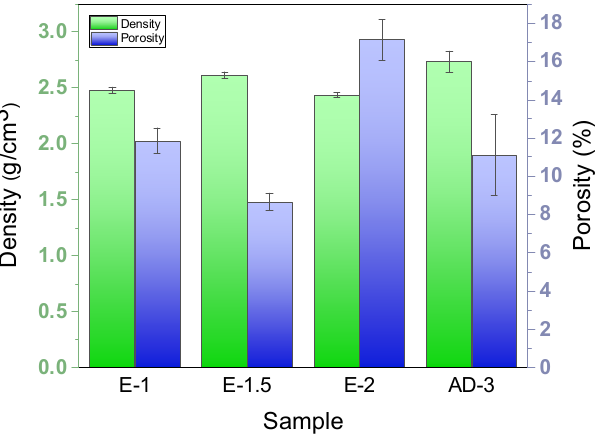
Figure 7. Histogram of the density and open porosity of the SiCNW-reinforced SiC f /SiC